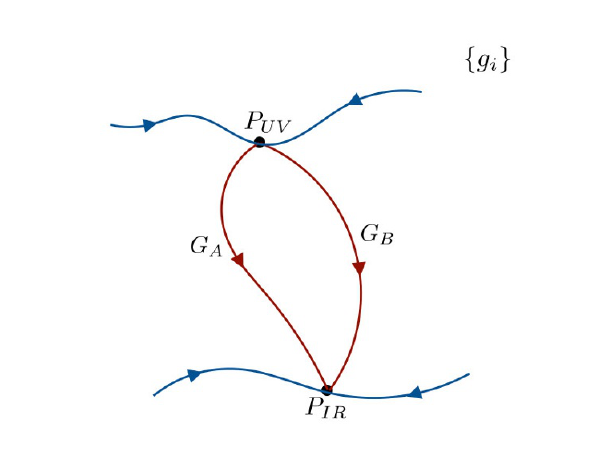
Figure 1 . Possible RG trajectories between two (cid:12)xed points, following [1]. Red lines denote relevant trajectories from P UV , while blue lines are associated to irrelevant